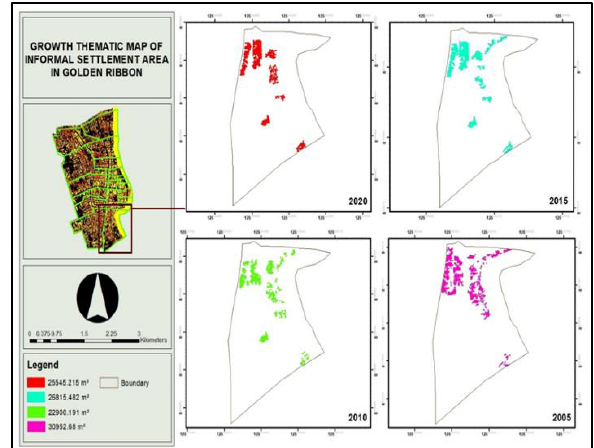
Figure 13. Thematic Map of Brgy. Golden Ribbon from